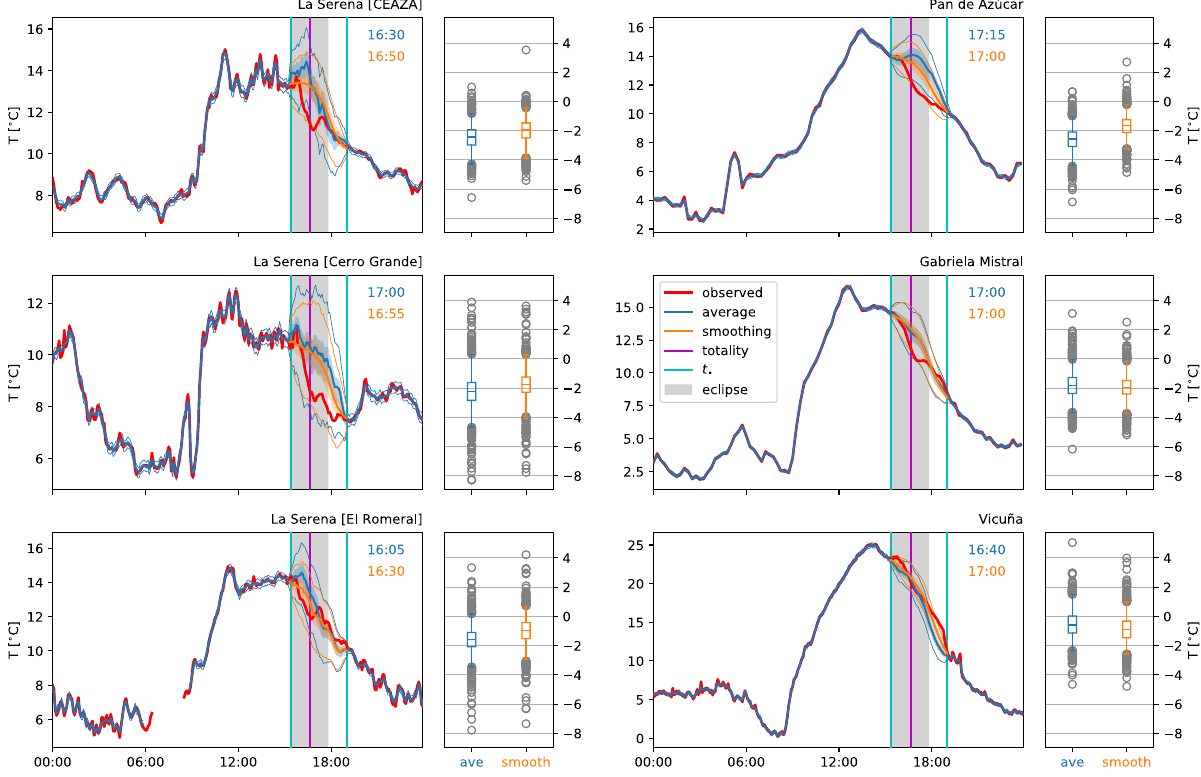
Figure 1. Observed 2m air temperatures on the day of the eclipse (July 2nd, 2019), together with estimates of the ‘uneclipsed’ temperature evolution, for selected stations in the vicinity of La Serena, Chile (left plot of each panel). The reference estimates are obtained from average (‘ave’) and smoothing (‘smooth’) style lasso regressions. Box plots (right) show maximum temperature depression for each estimation method, with corresponding times in the right upper corners of main plot. Boxes (right) and shaded bands (left) correspond to the IQR, whiskers (right) and thin lines (left) to 95% of the